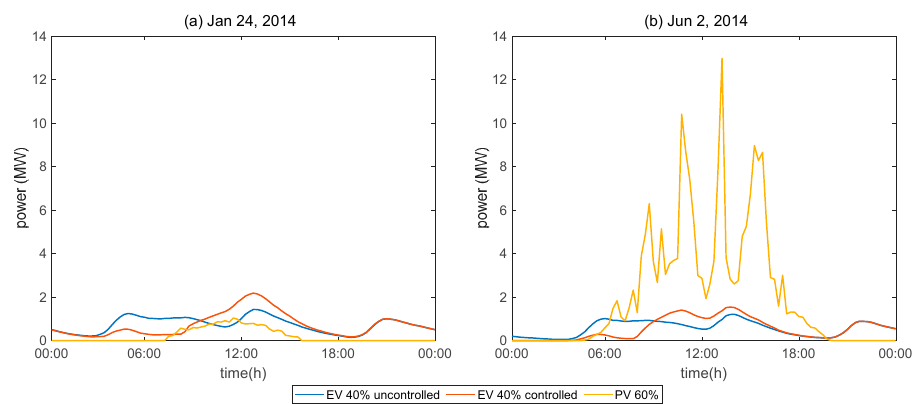
Figure 16. PV potential profile and synthetic charging load profiles for the e-mobility with 3.7 kW charging power, charging strategy 1 and 2 for cell 13 ( a ) 24 January ( b ) 2 June.